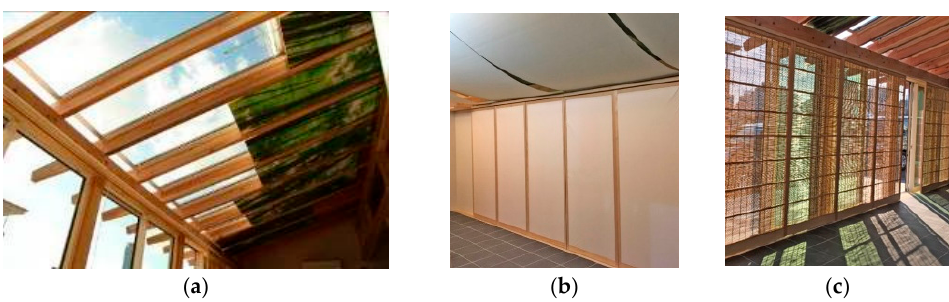
Figure 2. South façade of proposed ZEH.